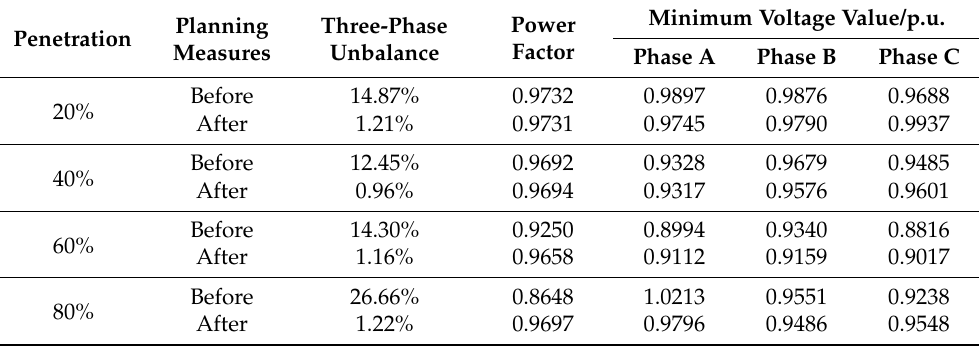
Figure 11. Spectrum analysis of harmonics at PCC under different penetration rates. ( a ) Penetration 20% Harmonic Spectrum Distribution. ( b ) Penetration 40% Harmonic Spectrum Distribution. ( c ) Pen- etration 60% Harmonic Spectrum Distribution. ( d ) Penetration 80% Harmonic Spectrum Distribution. Table 5. Statistical table of power quality evaluation